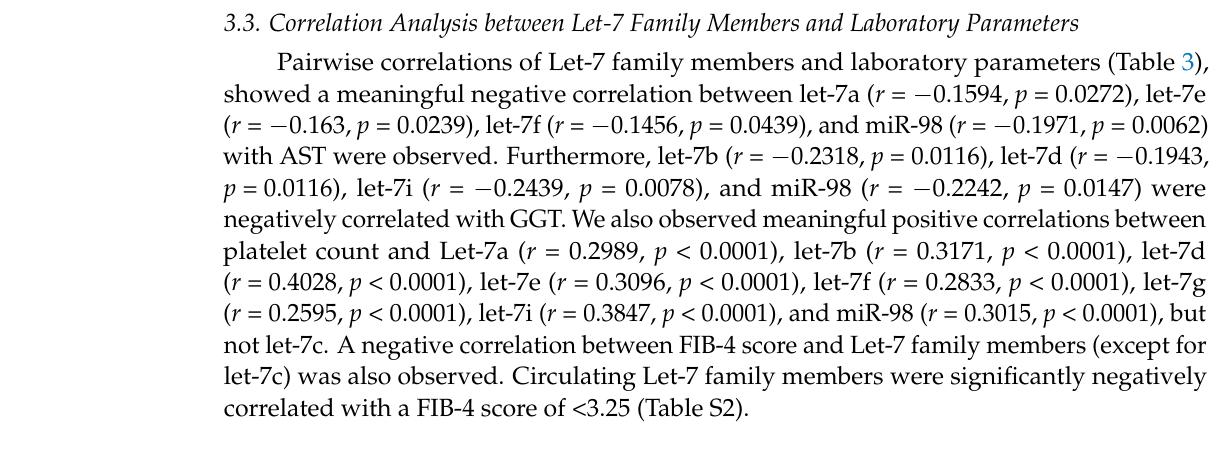
Table 3. Pairwise correlation coefficients were calculated for the Let-7 family and laboratory parame- ters at post-anti-viral treatment